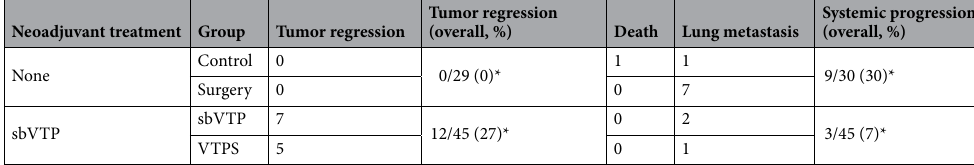
Table 1. Tumor regression and systemic progression by treatment group prior to surgical resection. sbVTP sub-ablative vascular-targeted photodynamic therapy, VTPS sub-ablative vascular-targeted photodynamic therapy followed by surgical resection of tumor. One control animal was censored from the tumor regression analysis due to death prior to surgery day. * P <